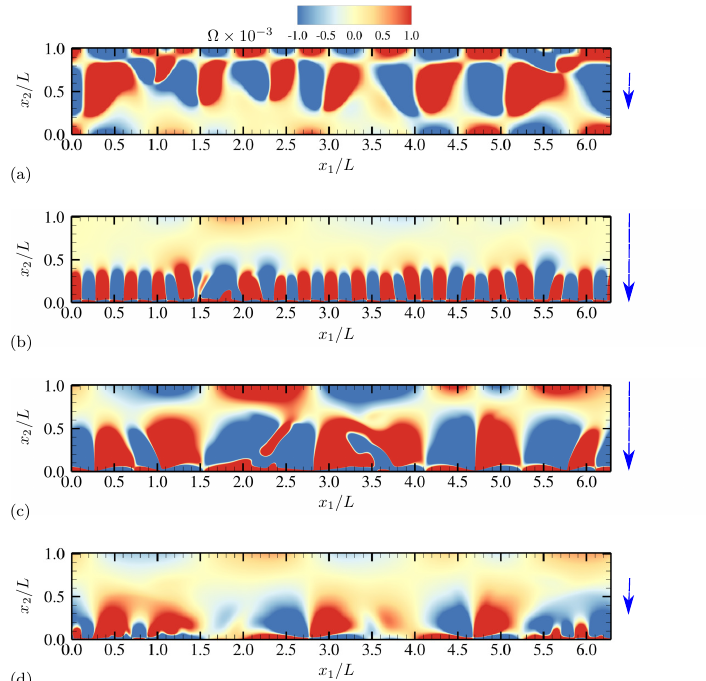
Figure 22. Time series of vorticity Ω for half an oscillation period at ( a ) θ = 0.64 π , ( b ) 0.88 π , ( c ) 1.12 π and ( d ) 1.4 π . The vertical arrows denote the direction and relative magnitude (not to scale) of the applied electric field. The diffusivity ratio is D − / D + =